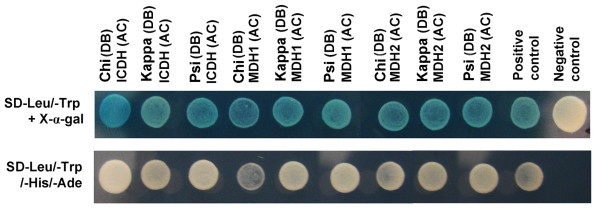
14-3-3 proteins interact with TCA cycle enzymes in yeast. Three 14-3-3 isoforms interact with isocitrate dehydrogenase (ICDH, At4G35650) and two malate dehydrogenases (MDH1, At1G04410; MDH2, At5G43330) that were previously isolated as possible targets of 14-3-3 proteins. AC indicates a pGADT7 and BD indicates a pGBKT7 vector. The positive control and negative control were described in methods section.